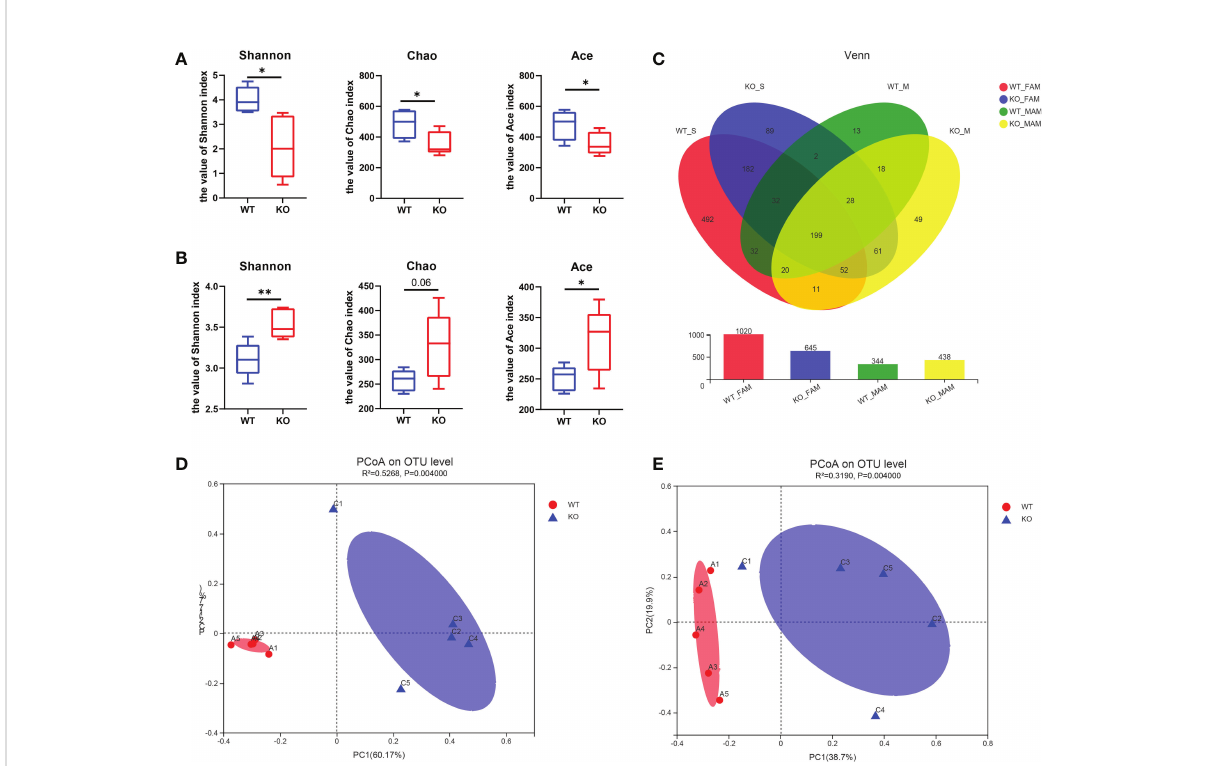
FIGURE 4 Characteristics of the alpha diversity in the two groups of mice. (A, B) Simpson index, Shannon index, Chao1 index, Ace index and Sobs index of FAM (A) and MAM (B) in each group (n=5). (C) Venn diagram showing exclusive features per group. (D, E) Plots of unweighted UniFrac principal coordinates were scored on the relative abundance of OTUs (97% similarity level) in the WT and GC Piezo1-/- groups. Each dot denotes a sample. Red dots represent the WT group, and blue dots represent the GC Piezo1-/- group. Differences were assessed by the Mann − Whitney- Wilcoxon test and denoted as follows: *, P < 0.05; **, P < 0.01; OTU, operational taxonomic unit; FAM, fecal-associated microbiota; MAM, mucosa-associated